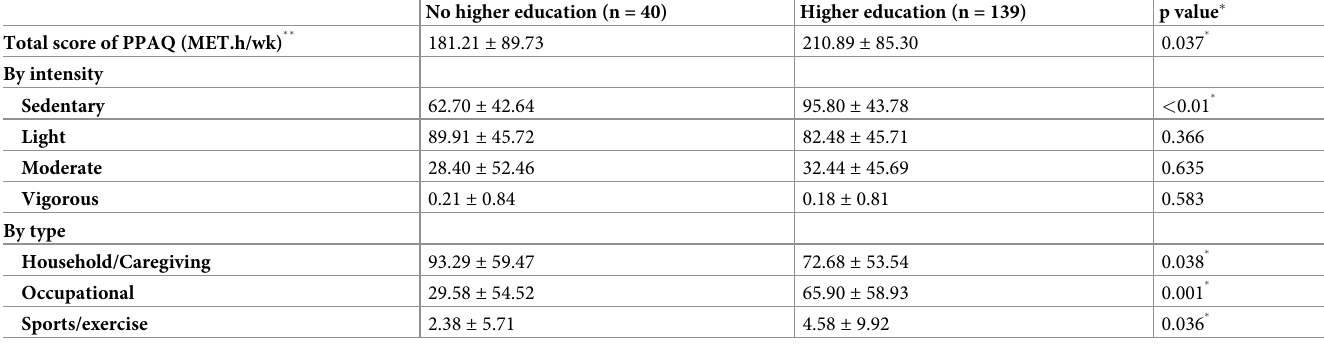
Table 2. Type and intensity of PA, deducted from the PPAQ, in women categorized depending on their educational level (N = 179).